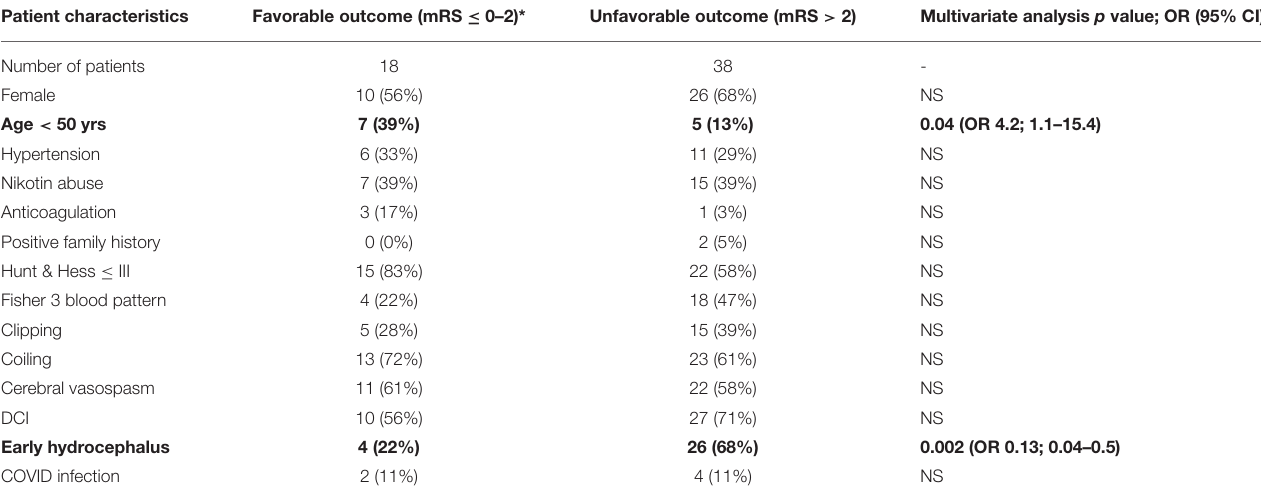
TABLE 4 | Clinical outcome in association with patient characteristics in patients with aSAH during 1 year of COVID-19 pandemic (03/20-02/21) w/o previous COVID Infection. Patient